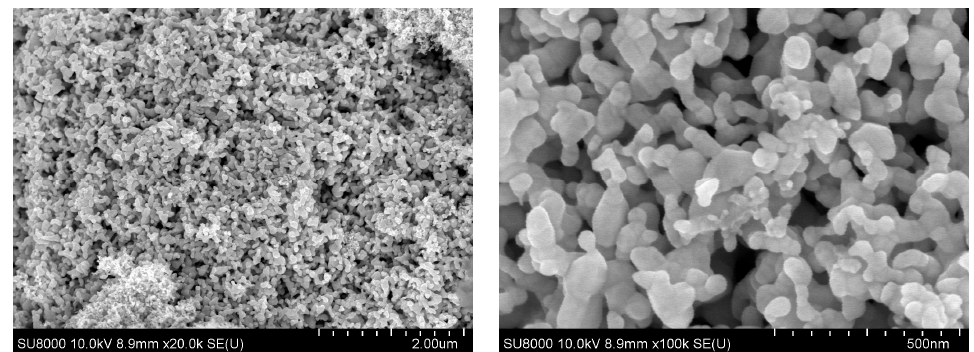
Figure 4. Au NPs SEM micrographs at various magnifications.